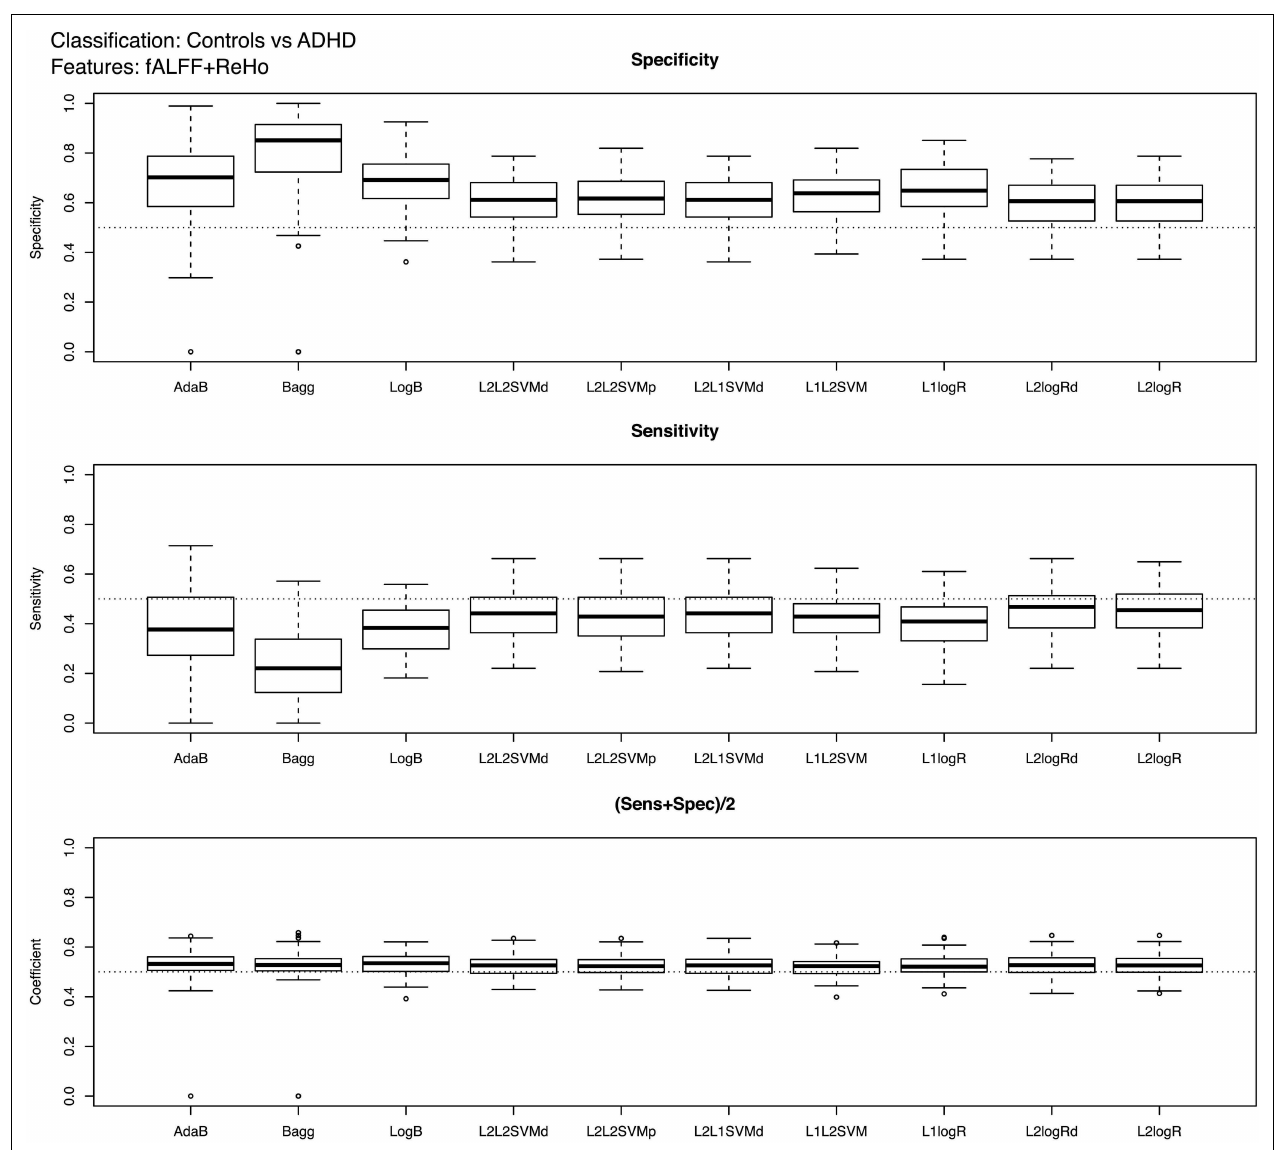
FIGURE 2 | Boxplots of the performance measures in control vs.ADHD patients classification when using fALFF + REHO